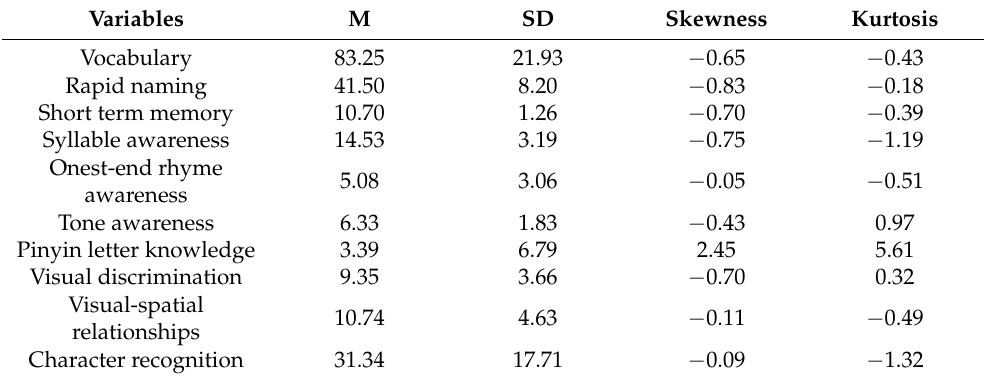
Table 1. Means, standard deviation, skewness and kurtosis of all the measures for the participants (N = 80). Variables